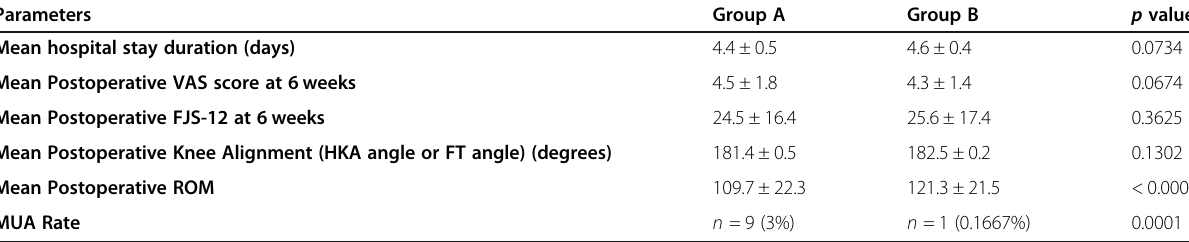
Table 2 Comparison of postoperative characteristics of patients between Group A and Group B Parameters